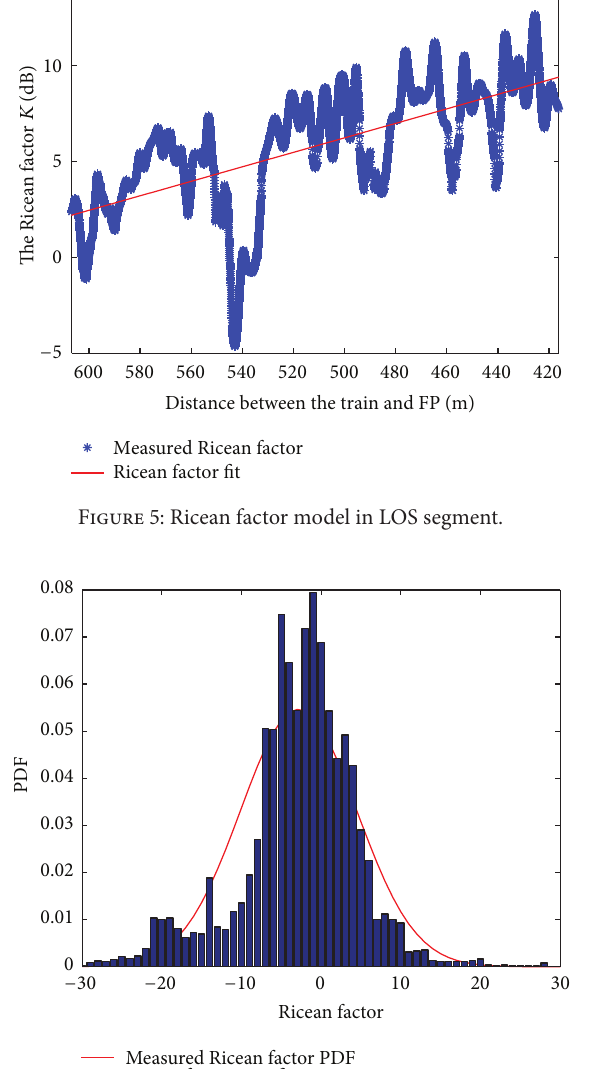
Figure 6: Statistical characteristic of Ricean factor in OLOS seg- ment.